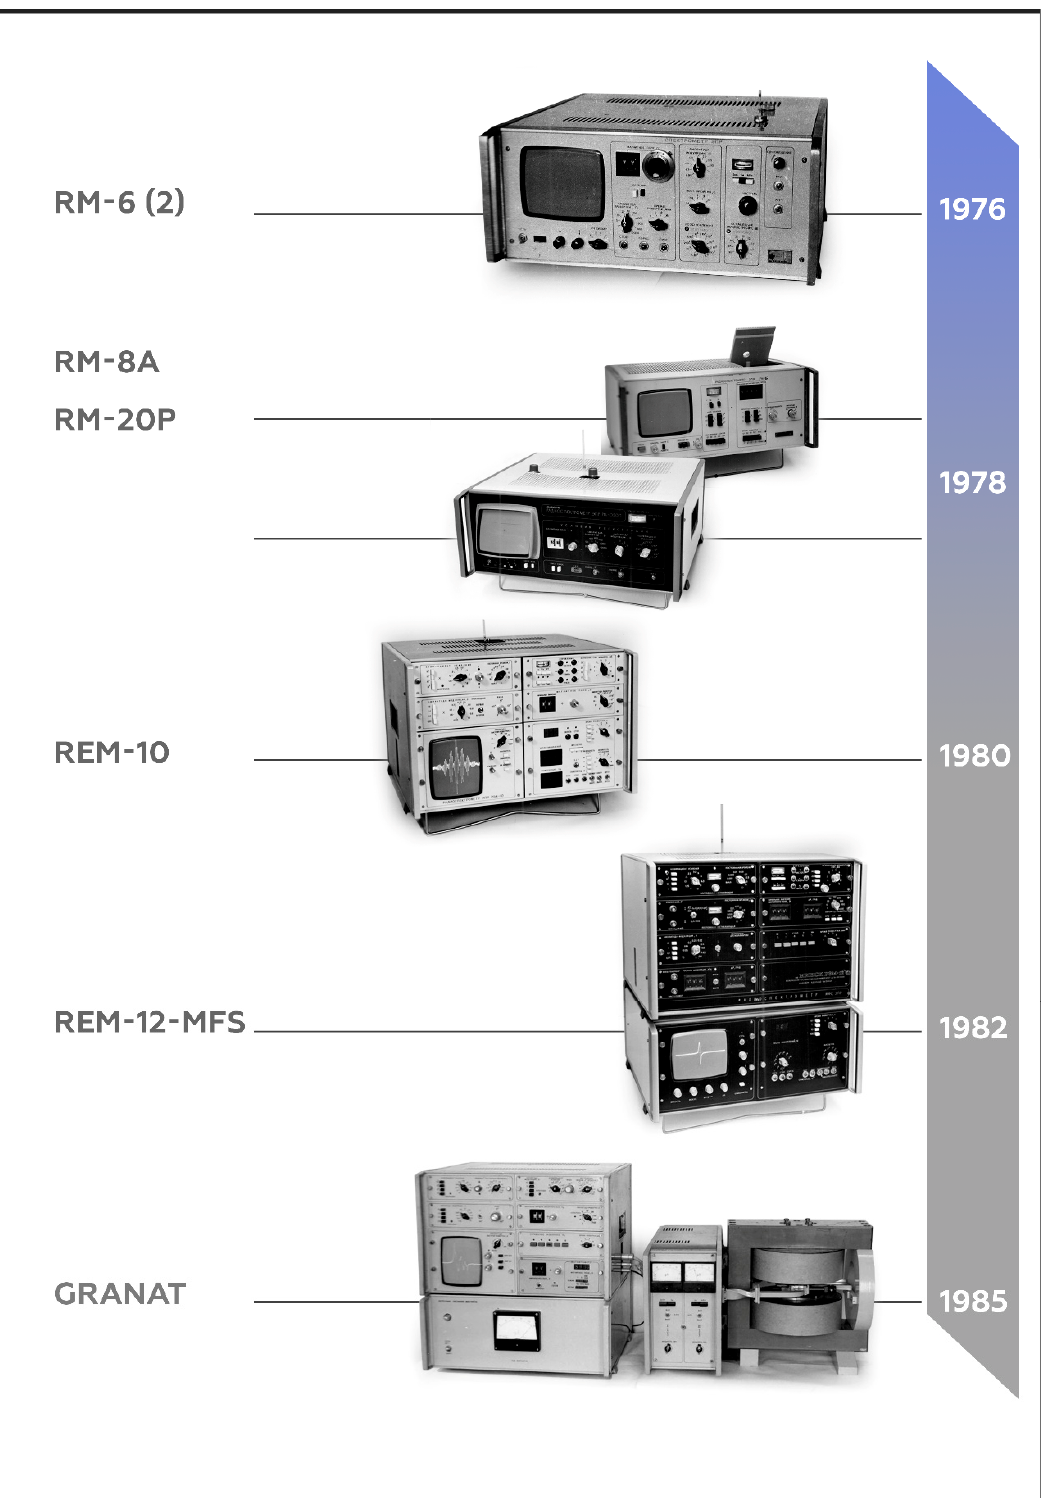
Figure 6. Family of benchtop EPR spectrometers developed and serially produced (in small series) by 1985.